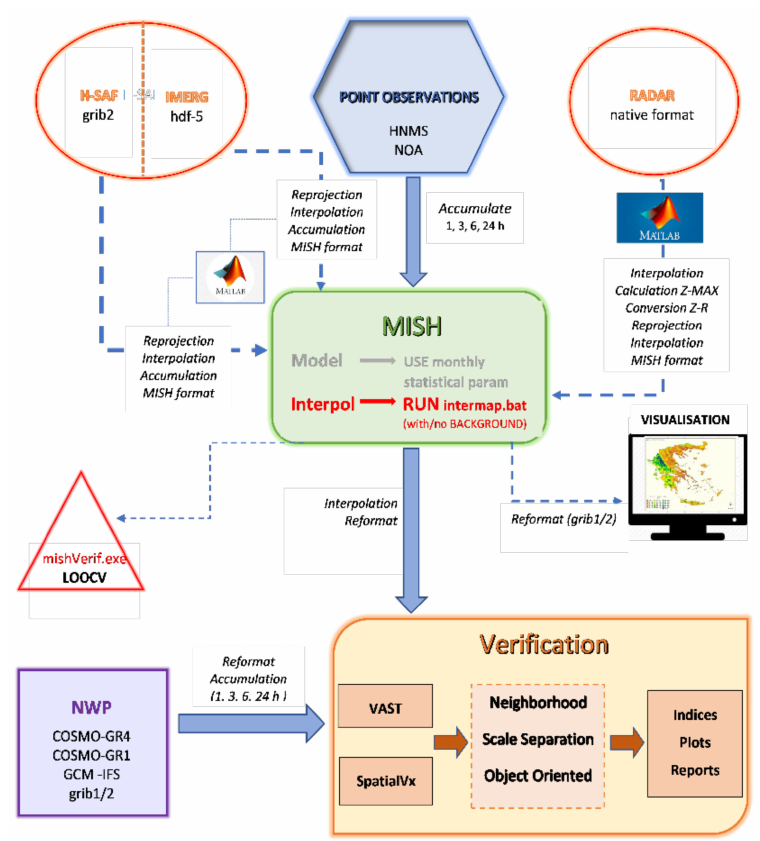
Figure 1. Schematic of the Integrated Forecasting Evaluation